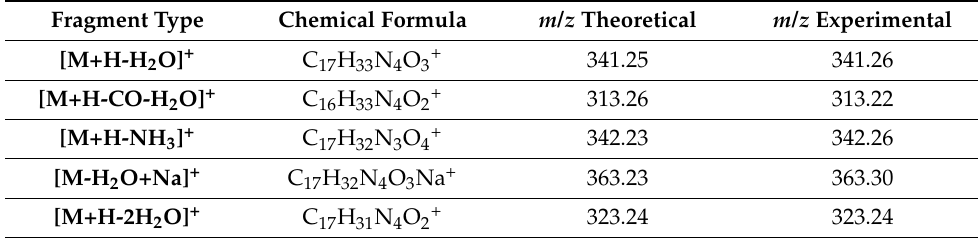
Table 5. Additional types of fragments identified for Val-Ile-Lys peptide. Fragment Type Chemical